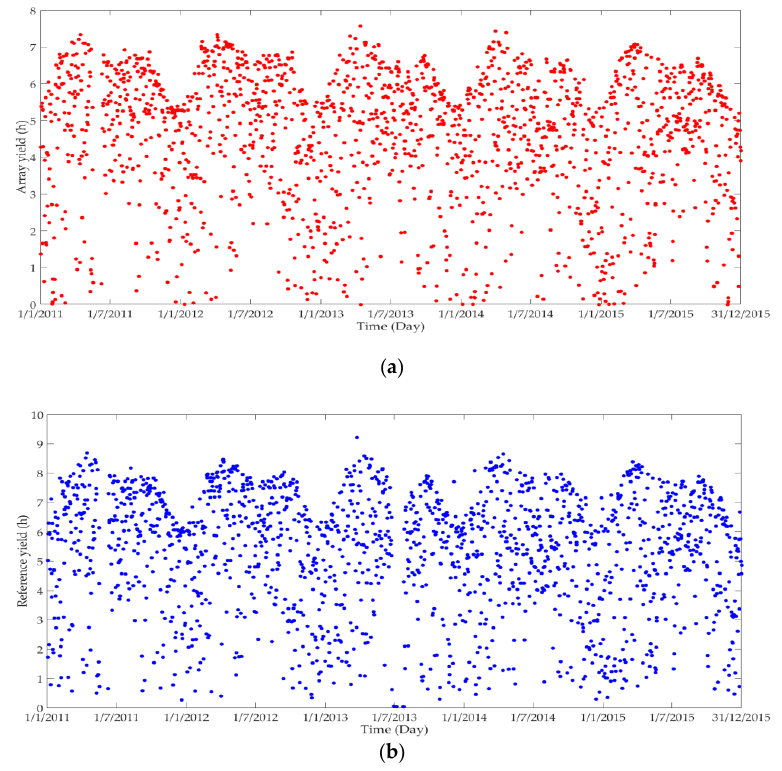
Figure 4. Daily yields from 1 January 2011 to 31 December 2015: ( a ) array yield; ( b ) reference yield.